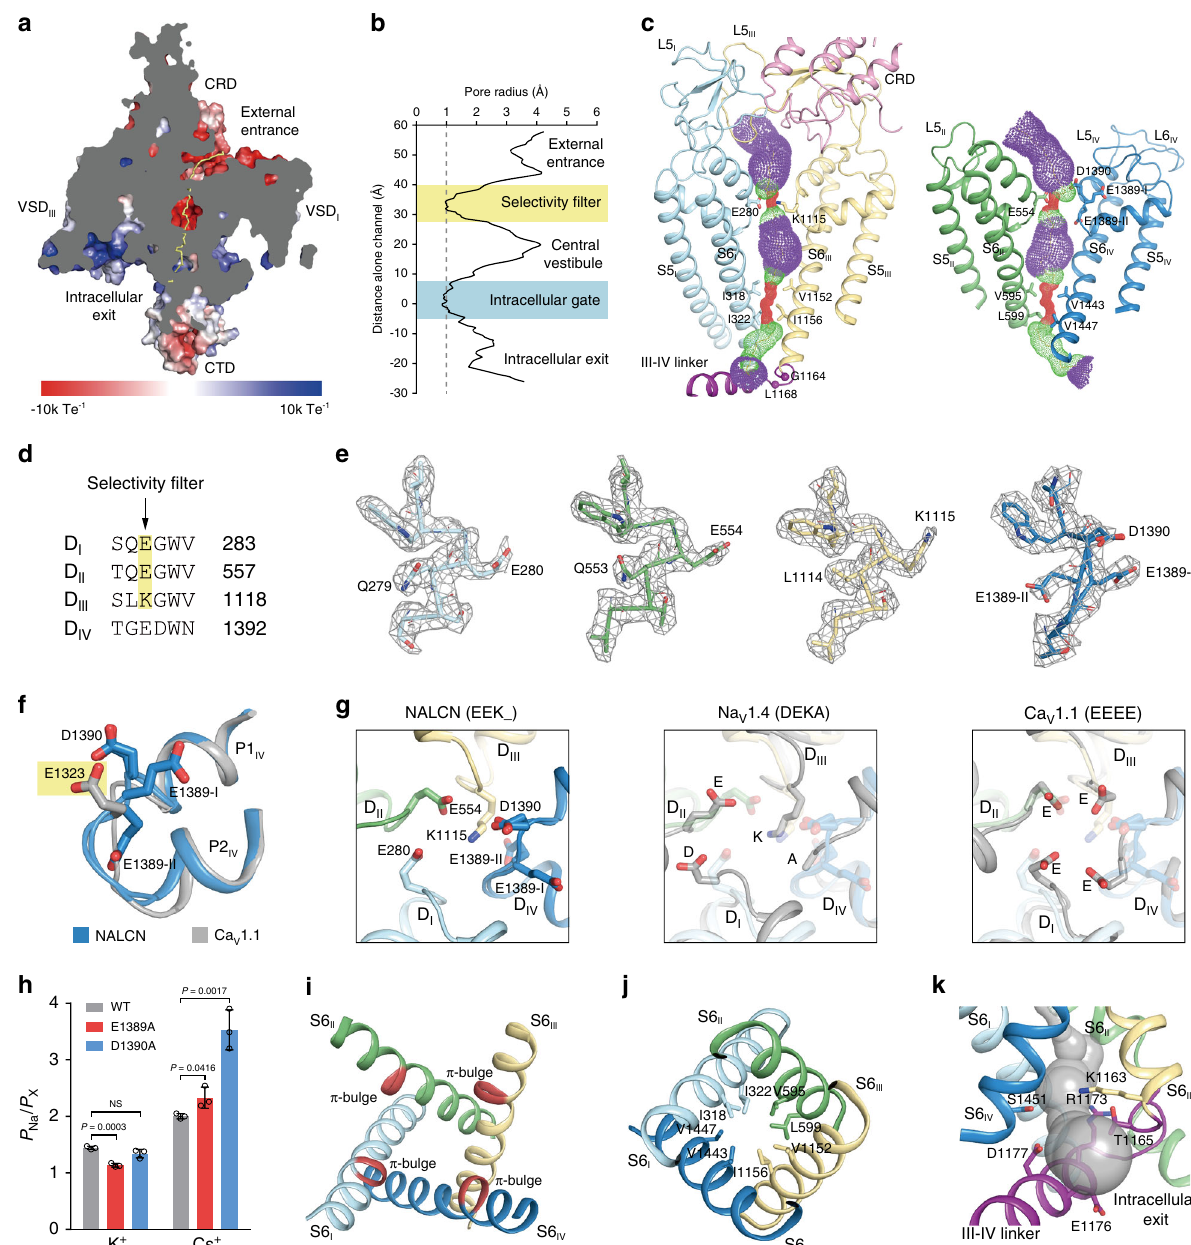
Fig. 3 Structure of the pore domain of NALCN. a A cut-open side view of NACLN and FAM155A complex. The surface electrostatic potential is calculated by APBS 51 . The ion permeation pathway is shown as a yellow line. b Pore pro fi le of NALCN channel shows two constrictions. c The ion permeation pathway of the pore domain, calculated with HOLE 52 , is shown as color dots. Purple, green, and red dots represent pore radii >2.8 Å, 1.4 – 2.8 Å, and <1.4 Å, respectively. d Sequence alignment of the residues around the selectivity fi lter of rat NALCN. Residues that participate in ion permeation are highlighted in yellow. Residues for predicted selectivity fi lter are indicated with an arrow. e Densities of the selectivity fi lter of each repeat, shown as gray mesh, are contoured at 3.5 σ . f Side view of the structural comparison of domain IV between Ca V 1.1 (gray) and NALCN (blue). Key residues are shown as sticks. The yellow box indicates the approximate position of the high fi eld strength layer of the selectivity fi lter. g Structural comparisons of the selectivity fi lter of NALCN, Na V 1.4 (PDB: 6AGF), and Ca V 1.1 (PDB: 5GJV). Key residues are shown as sticks. h , Relative ion permeability ratios ( P Na / P X ) of NALCN and its mutants. Data are presented as mean ± s.d., n = 3 biologically independent cells. Two-tailed unpaired Student ’ s t -test was applied, and P -values were indicated in the fi gure. P < 0.05 was considered statistically signi fi cant. NS no signi fi cance. Source data are provided as a Source Data fi le. i Structure of S6 segments. π -bulges are highlighted in red. j Top view of the intracellular gate, hydrophobic residues forming the narrowest constrictions are shown as sticks. k Side view of the intracellular exit for sodium. The gray surface represents the calculated ion permeation